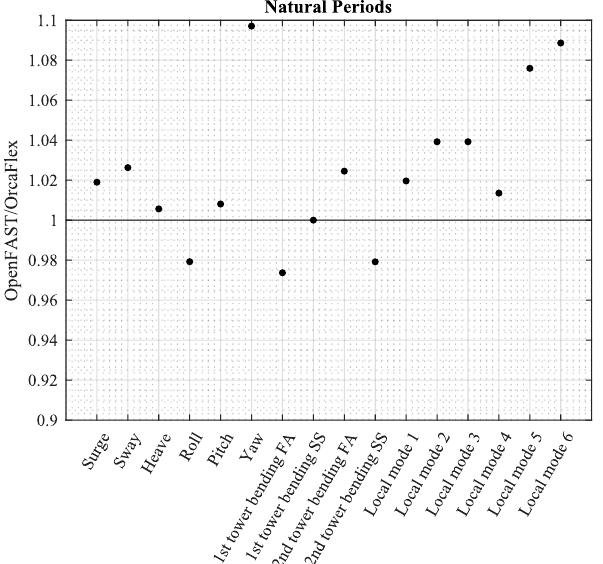
Figure 6. Comparison of natural periods between OrcaFlex and OpenFAST. FA and SS indicate fore/aft and side/side,